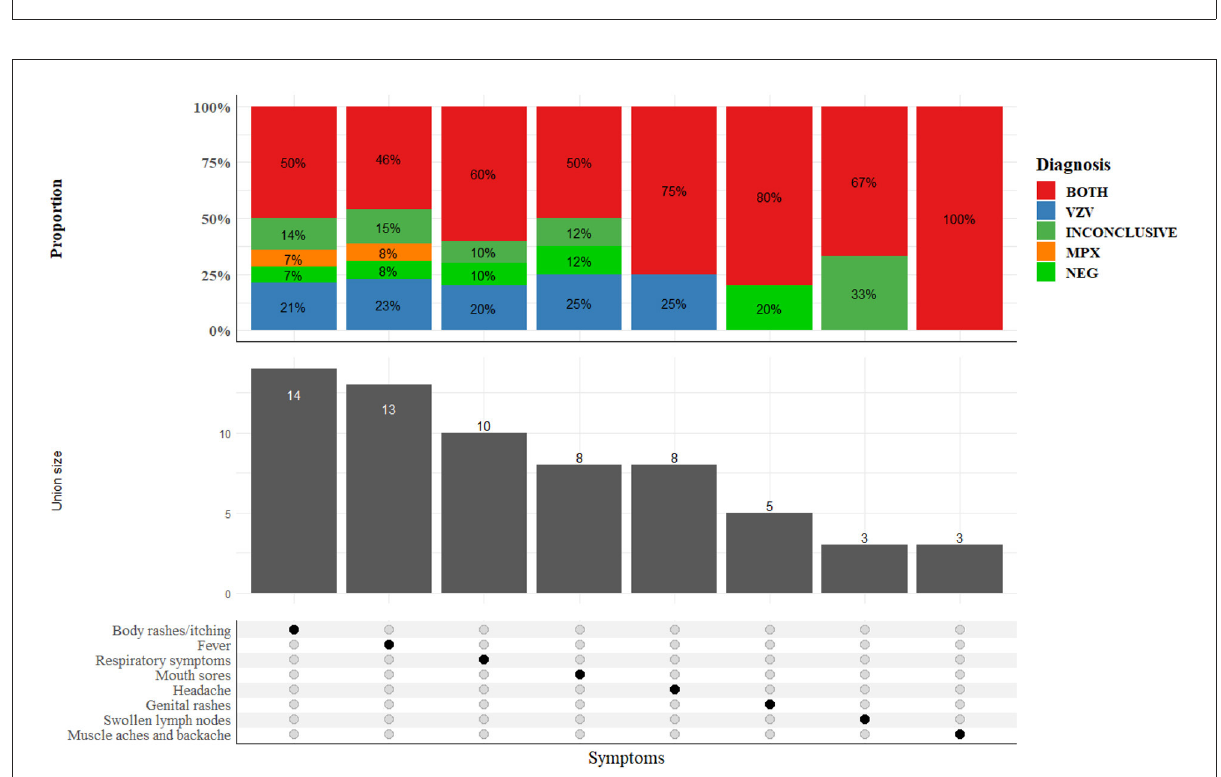
FIGURE4 Clinical characteristics among 14 patients included in the follow-up survey.